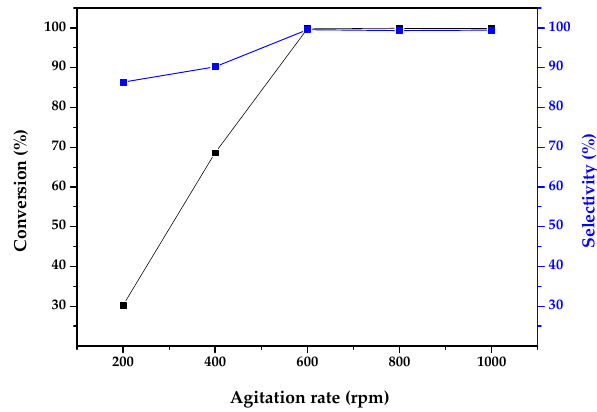
Figure 9. Impact of reaction stirring rate on the conversion (black) and selectivity (blue) in the selective hydrogenation of p ‐ CNB. Reaction conditions: 1 g 0.27 wt % modified Pd/ γ ‐ Al 2 O 3 @ASMA treated with 100 g/L morpholine, 1 g p ‐ CNB dissolved in 50 mL ethanol, 80 °C, 2 MPa H 2 pressure, and 4 h in a 100 mL autoclave.